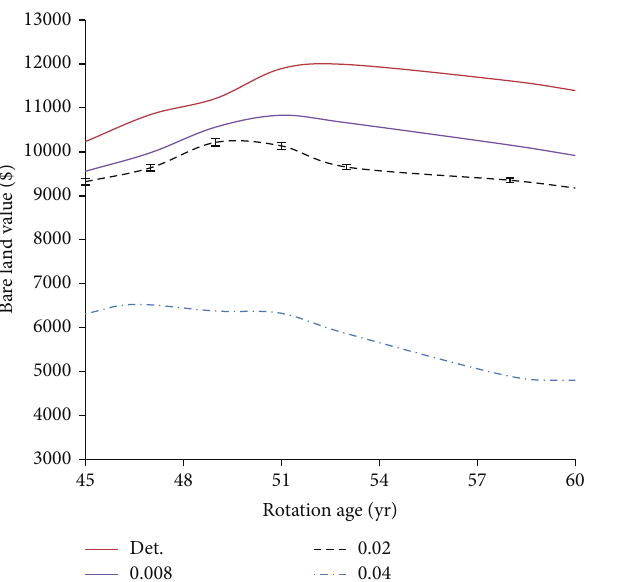
Figure 3: The effect of the increasing risk of a catastrophic insect outbreak on the bare land value of plot Dulaer 76 for different rotations. Legend numbers refer to annual probability of disaster. The discount rate is 3.5%.